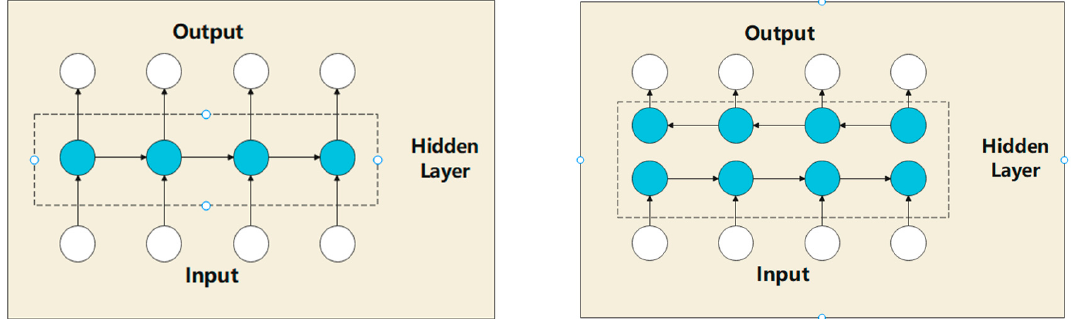
Figure 1. LSTM unit structure.